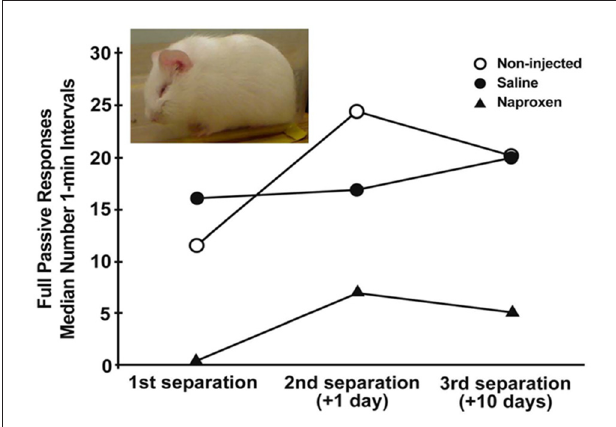
FIGURE 1 | Median number of 1-min intervals guinea pig pups spent exhibiting the depressive-like crouched stance with eye-closure and extensive piloerection (inset) during three, 3-h separations over a 11 days period. Pups were either not injected or were injected for the 3 days prior to the initial separation with either saline vehicle or 14 mg/kg naproxen in saline. Depressive-like behavior increased over separations across all groups ( p < 0.005). Further, the group given naproxen showed less of the behavior during each separation than did non-injected and saline-injected controls ( p ’s < 0.005; figure derived from Hennessy et al. (2015b) without permission